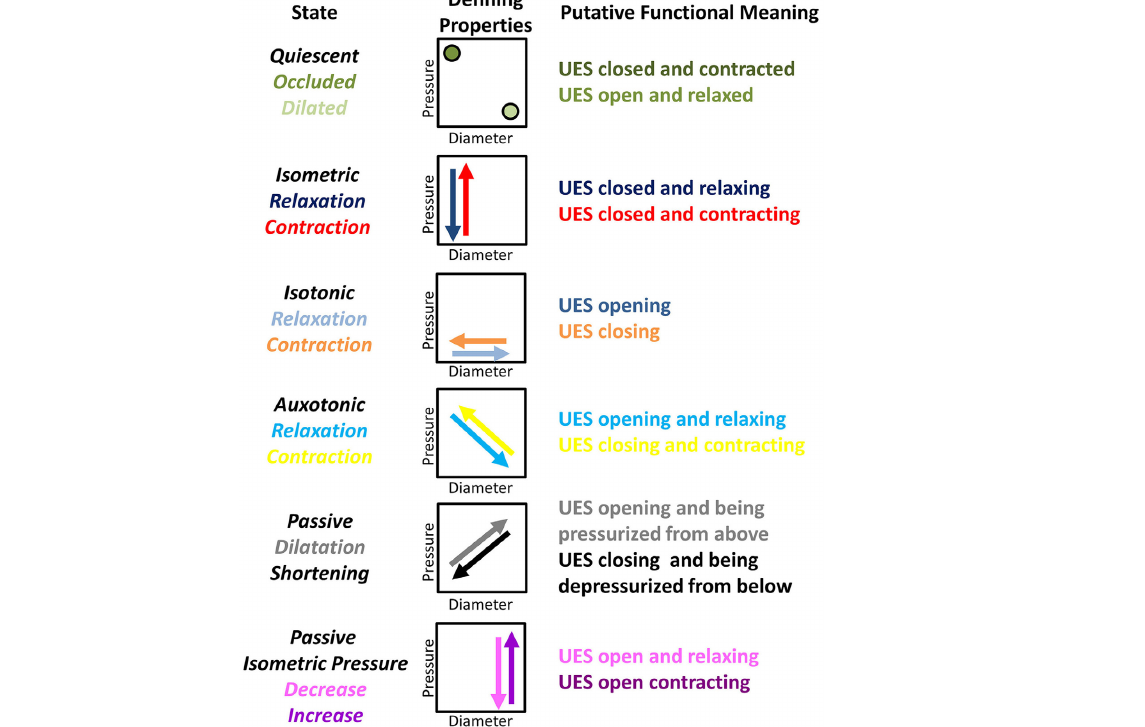
FIGURE 2 | Nomenclature and defining properties of 12 possible UES Mechanical States previously described in relation to propulsive peristalsis of the lower gut (Costa et al., 2013). The putative functional meaning when applied to the UES is also